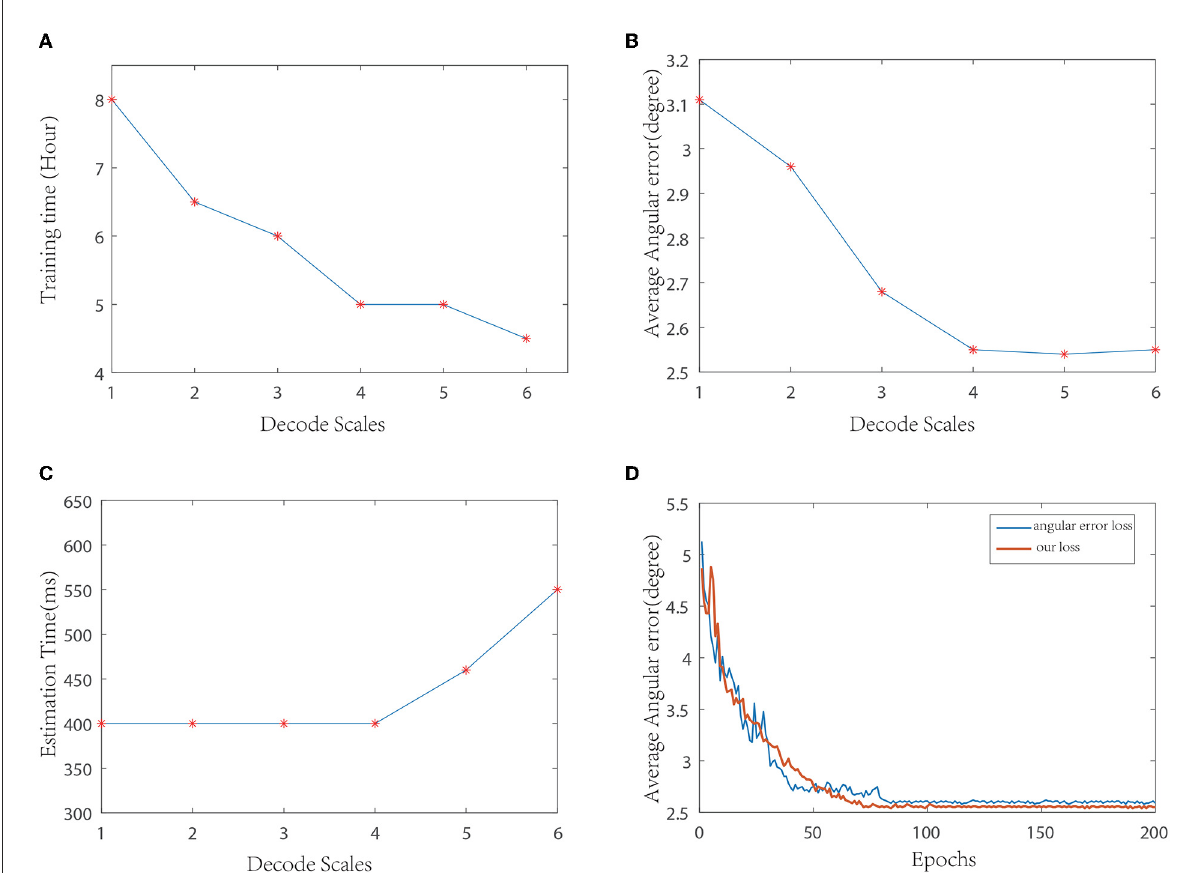
FIGURE3 Performance curves under different parameters. (A) Comparison of training time of different decoding scales; (B) Comparison of average angular errors of different decoding scales; (C) Comparison of average time consumption of illumination estimation at different decoding scales; (D) Comparison of training curves of different loss